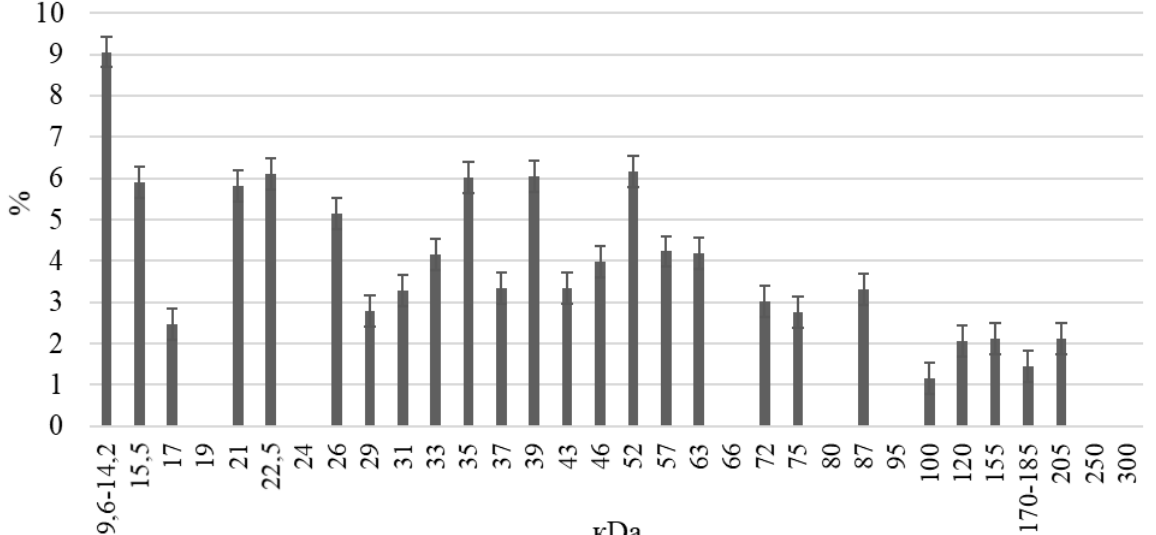
Fig. 1. Structural proteins of the apical membrane of the jejunum enterocytes of two-month-old cattle fetus (M ± m; %; n = 6) 250 kDa and 300 kDa (0.45 ± 0.01 % and 0.88 ± 0.01 %,